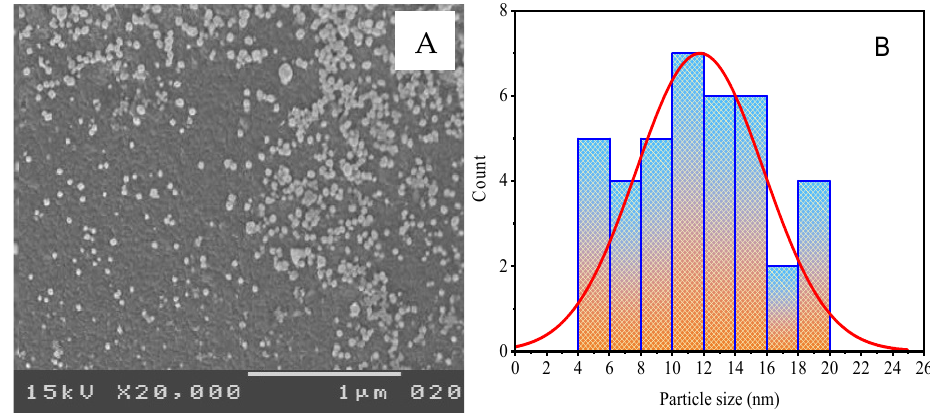
Figure 8. The as-biofabricated Ag NPs: ( A ) SEM image; ( B ) particle size distribution.